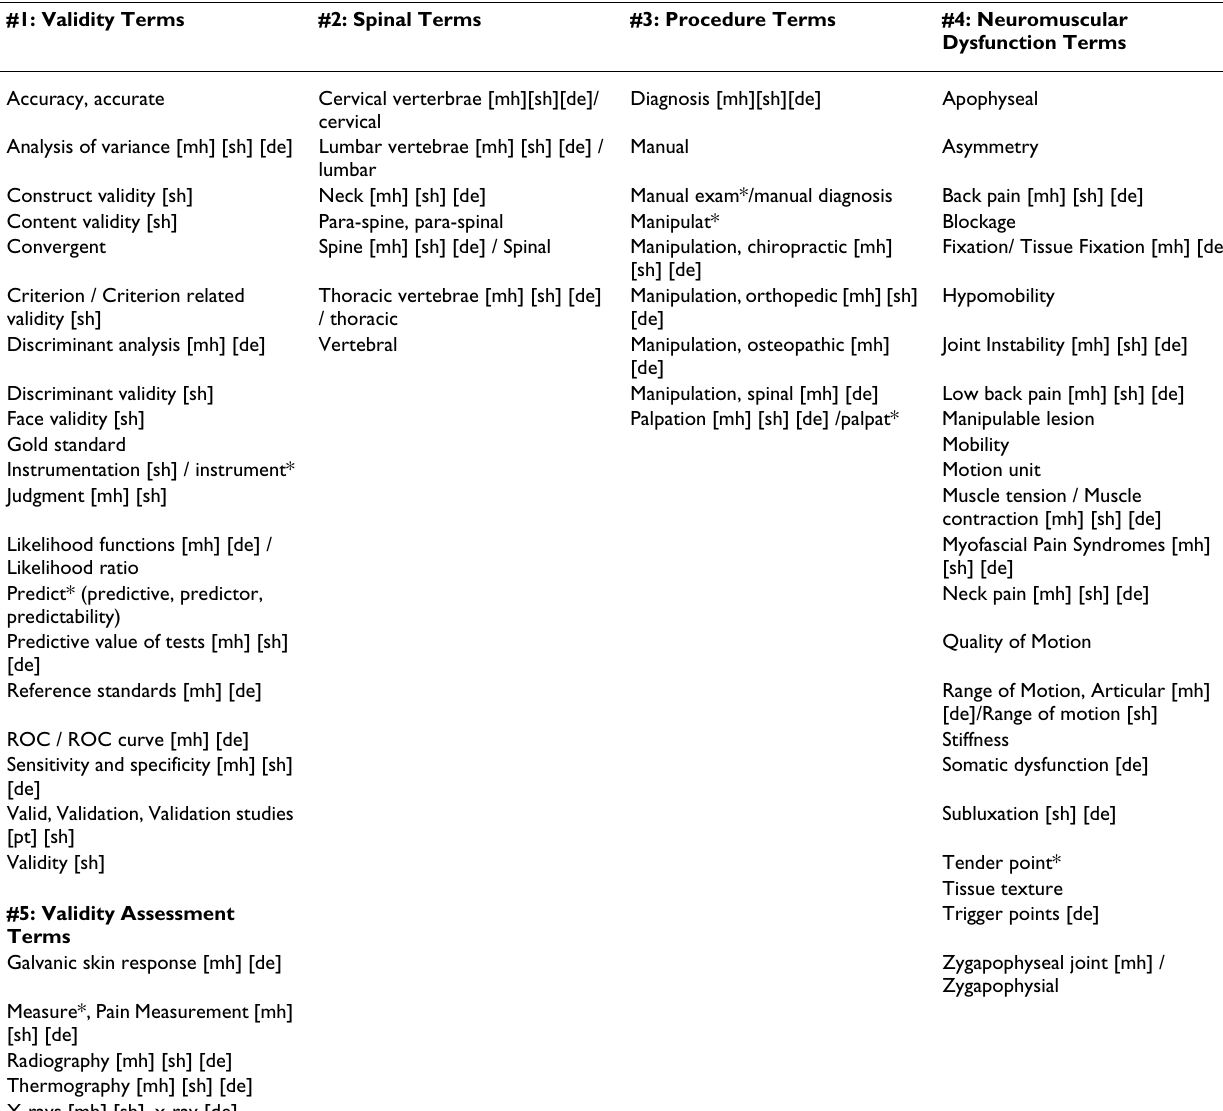
Table 1: Controlled vocabulary and keywords used to retrieve studies on the validity of spinal palpation #1: Validity